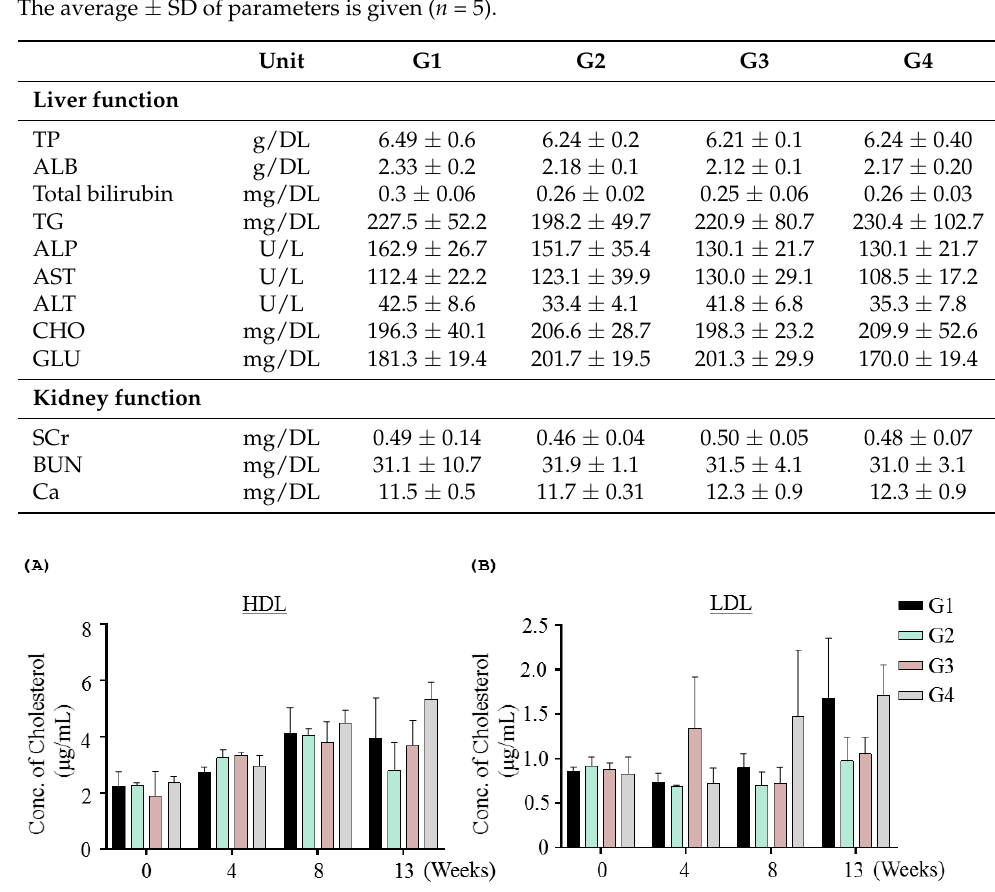
blockage have been found. The intensity of the pink color shows a negative contribution of